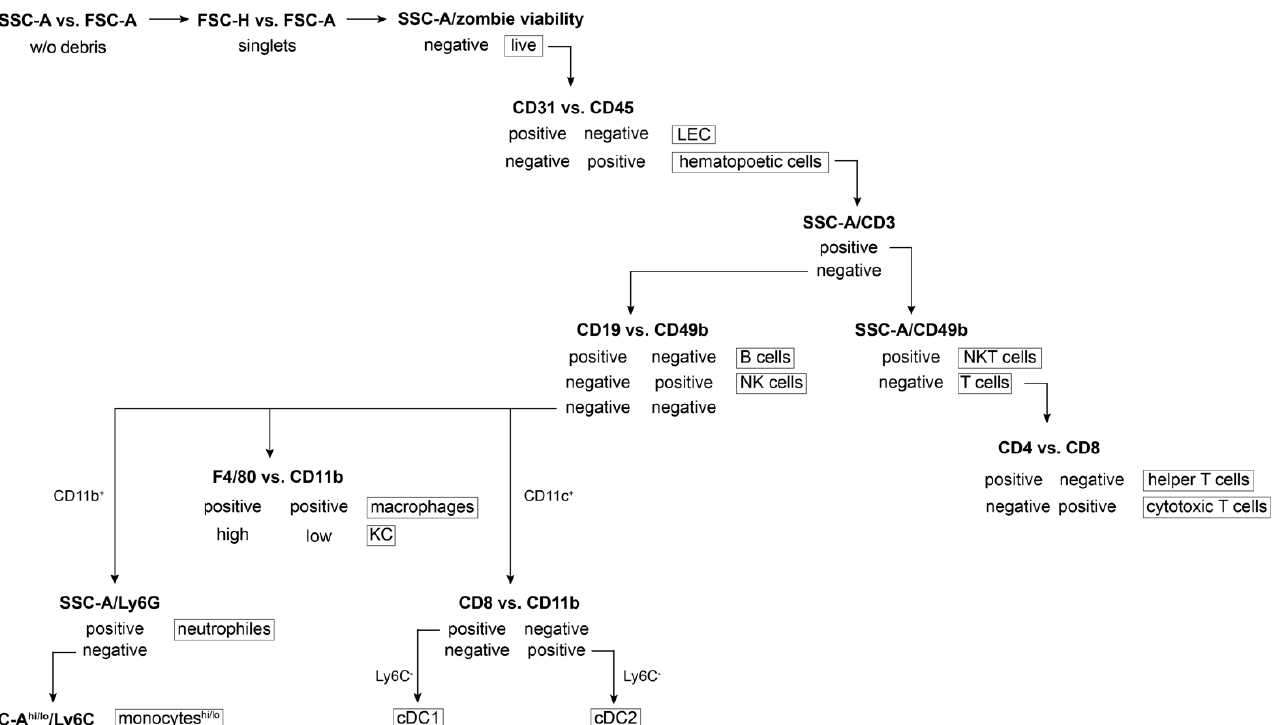
Figure 2. Illustrated work procedure. ( A ) Uncovered and stretched portal vein to perform perfusion. ( B ) Gradual liver perfusion. ( C ) Perfused liver. ( D ) Material preparation for dissociation. C-tube with cell culture medium, dissolved particular components of the liver dissociation kit (all Miltenyi Biotec, described from the left). ( E ) Liver placed into C-tube with the dissociation mix. ( F ) Liver homogenate after dissociation. ( G ) Filtrate of dissociated tissue. ( H ) Density gradient-based cell purification (layer of debris removal solution on top of the cell suspension; before centrifugation). ( I ) Obtained cells contaminated with leftover of red blood cells. ( J ) Final NPC yield after the removal of red blood cells.